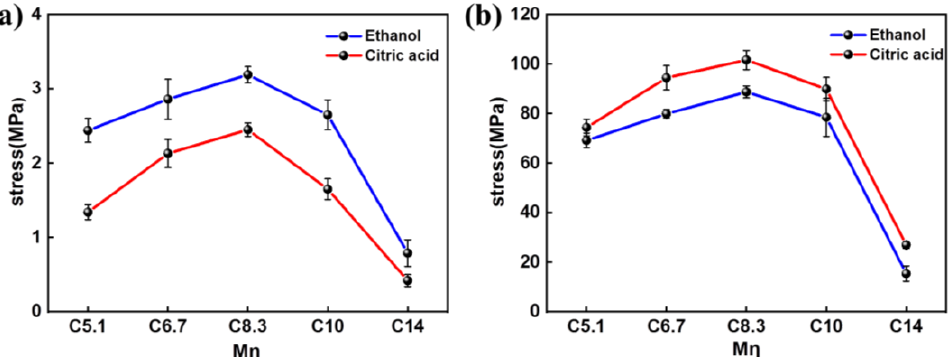
Figure 8. The tensile stress curves of hydrogels ( a ) and films ( b ) with M η of C5.1, C6.7, C8.3, C10, and C14.